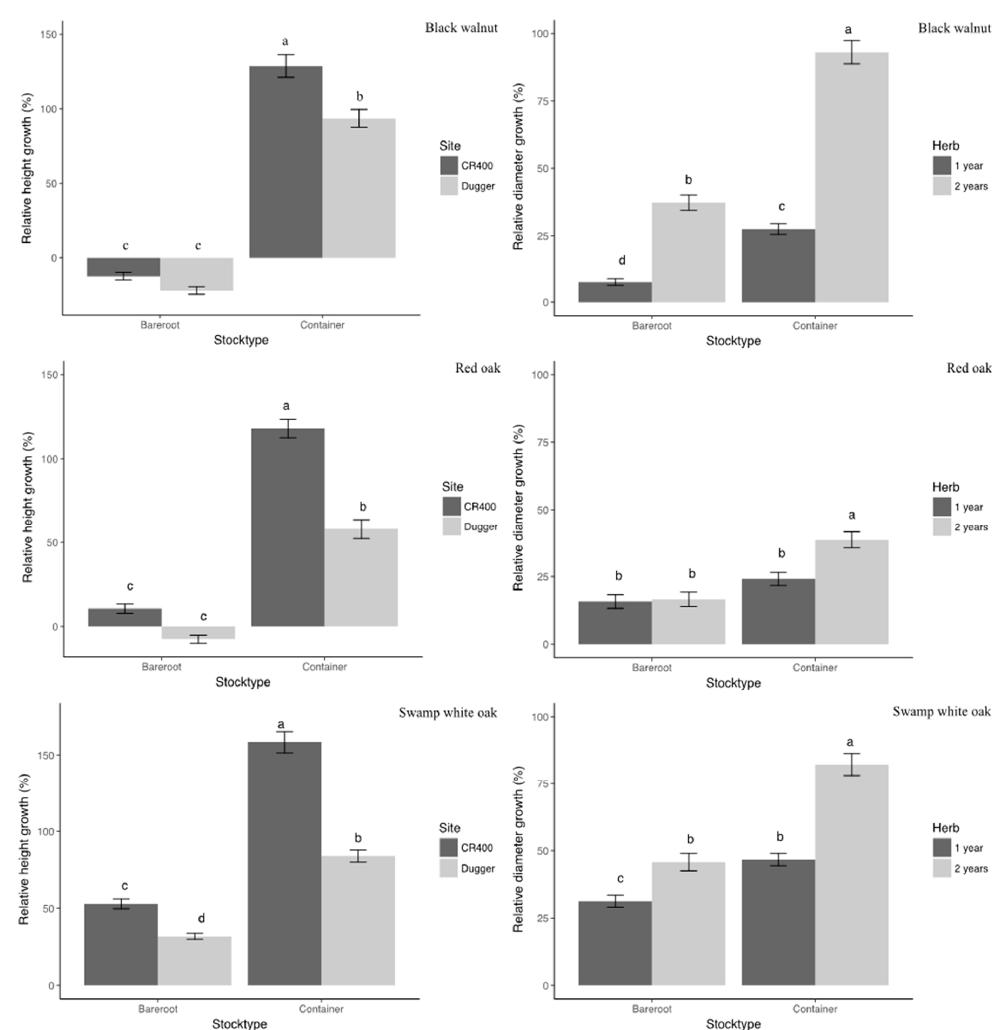
Figure 3. Relative height growth of black walnut, red oak, and swamp white oak for site × stocktype interaction (left side) after two years. Relative diameter growth for stocktype × herbicide interaction (right side) after two years. Columns are means, and error bars are (±SE). Columns with different letters are statistically different according to Tukey’s Honestly Significant Difference (HSD) test at α = 0.05.